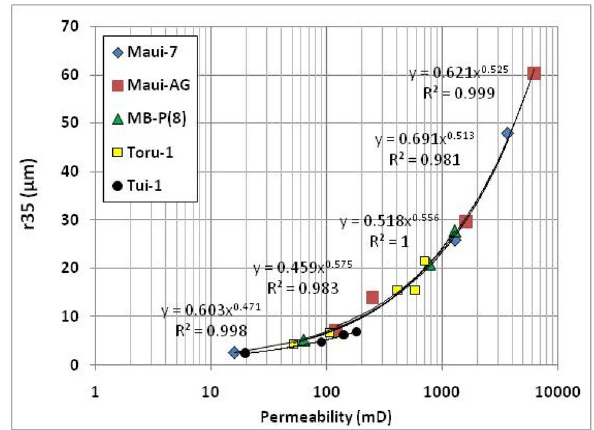
Fig. 11 Plotting of pore throat radii (r35) versus a horizontal perme- ability ( K H )